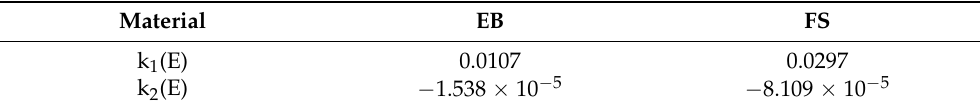
Table 3. Spectral parameter for extraction relative electron density (RED) of dual-energy image in energy bin (EB) and full spectrum (FS)